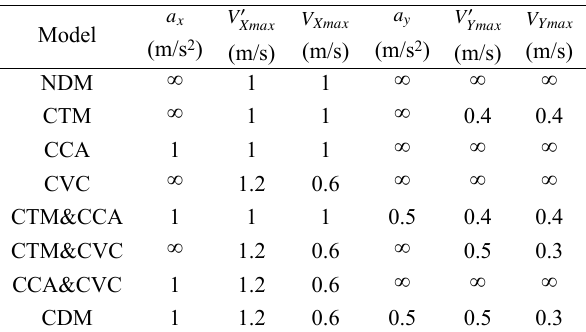
Table 3 Task list with 20 tasks.